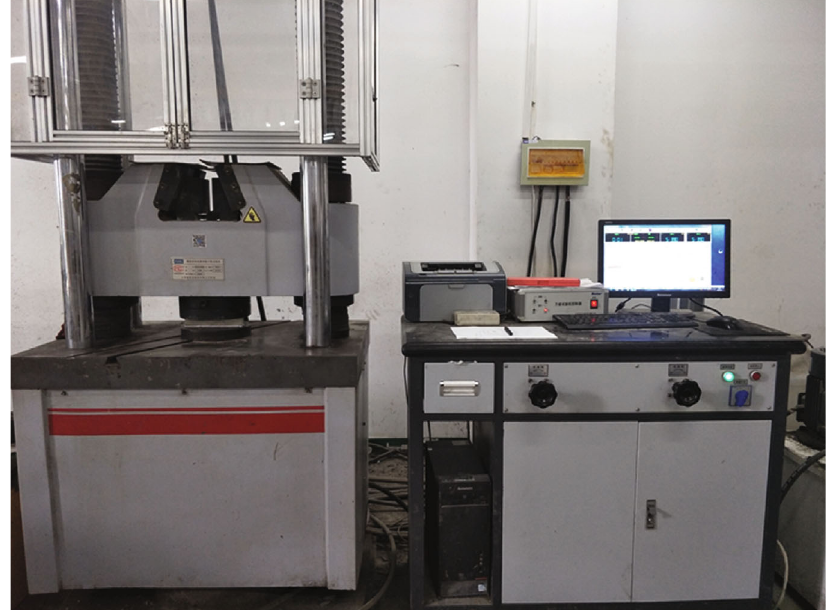
Figure 2: Picture of the experimental loading